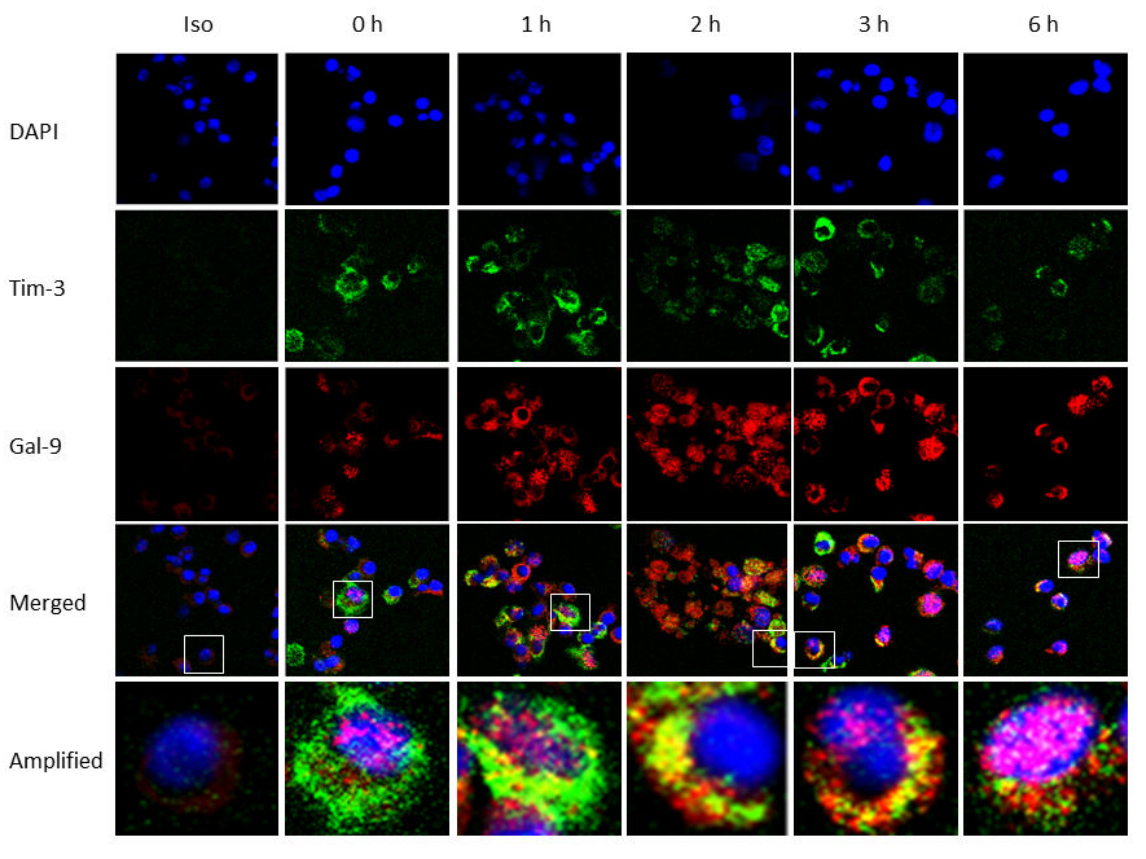
Figure 4. TLR stimulation enhances Tim-3/Gal-9 cis association that is co-localized intracellular of M/M and Gal-9 localization/co-localization in resting and TLR-stimulated M/M with LPS/R848 for 0, 1, 2, 3, 6 h; following fixation/permeabilization, intracytoplasmic Tim-3 and Gal-9 staining as well as DAPI nuclear staining (blue), isotype control staining, and their imaging merges observed by confocal microscopy as described in the Methods. Magnification 100x and 1.4 oil DIC (total of 140x) for all panels. A typical cell with Tim-3 (green) expression, Gal-9 (red) expression, and imaging merge as evidence of their co-localization (yellow) in M/M square) and further amplified